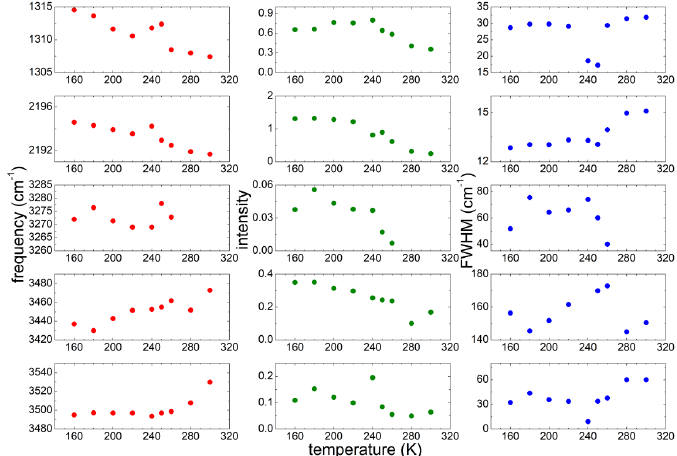
Figure 5. Temperature dependence of the parameters of the most significant absorption lines of PYR 14 -DCA measured on heating from 160 up to 300